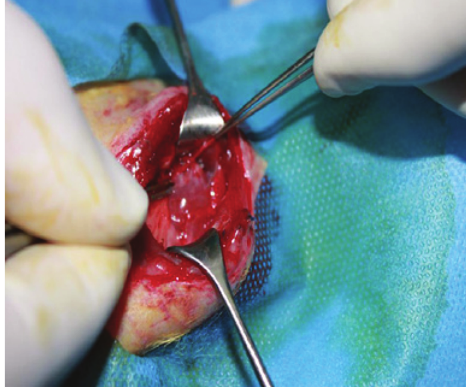
FIGURE 2 - Grade 3 adhesion in experimental group. TABLE 1 - Adhesion rate in two experimental and control